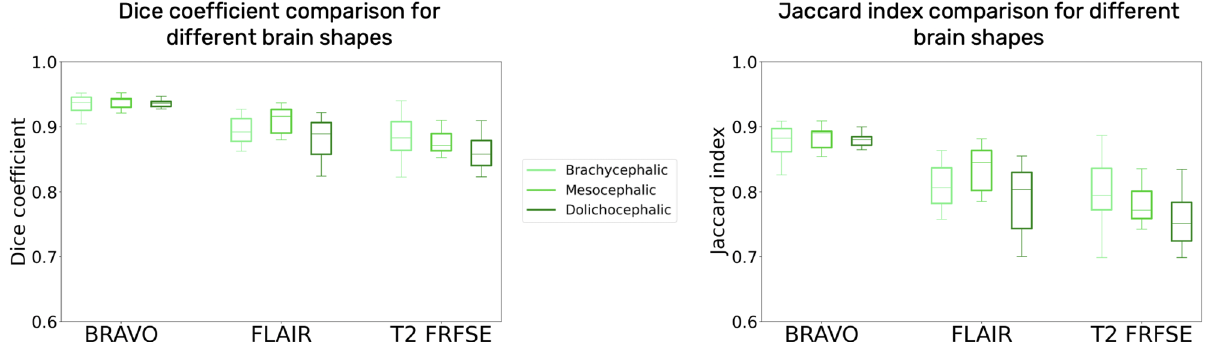
Figure 6. Dice similarity coefficient and Jaccard index Boxplot for the dogs cohort, comparing VIBE results for different cranial conformations (brachycephalic, mesocephalic, dolichocephalic), for three different sequences: T1 BRAVO, T2 FRFSE and T2 FLAIR.